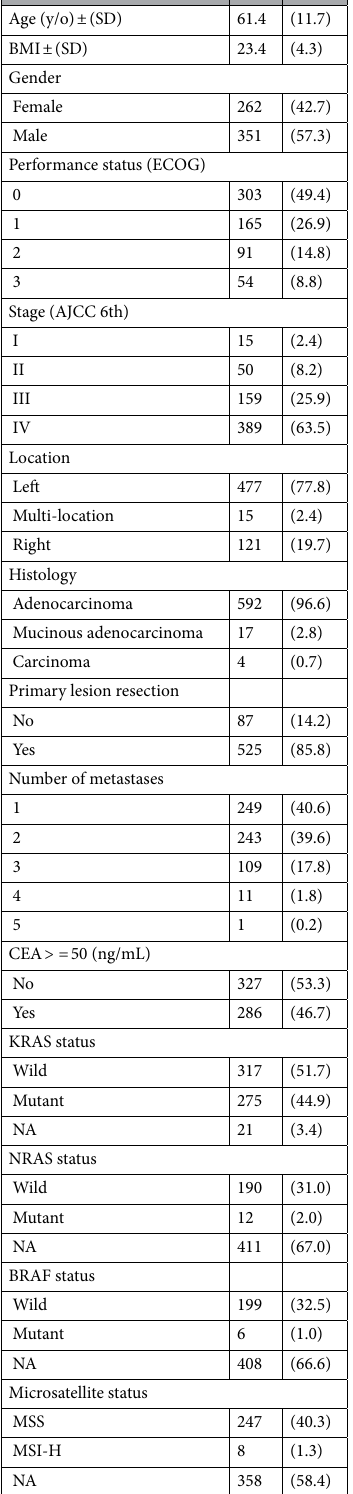
Table 1. Patients’ characteristics (n = 613). AJCC, American Joint Committee on Cancer; BMI, body mass index; CEA, carcino embryonic antigen; ECOG, Eastern Cooperative Oncology Group; NA,